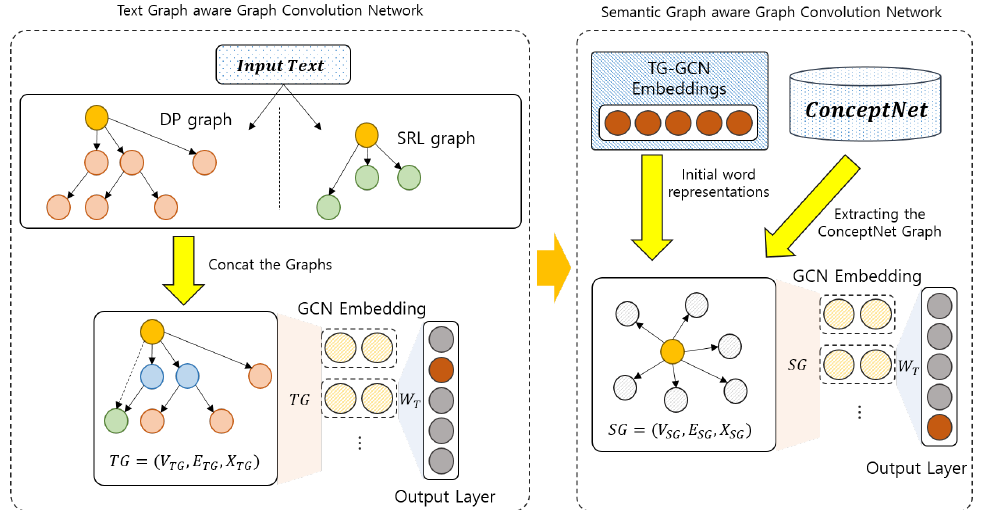
Figure 2. Overview of the proposed method. The model sequentially trains symbolic graphs of different properties in two